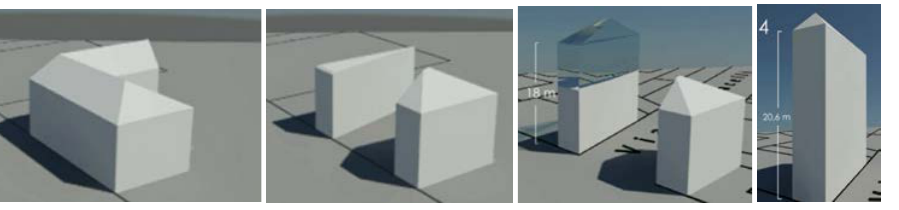
Figure 4. Location of Antonelli’s design inside Torino. The red ones are the not realized designs